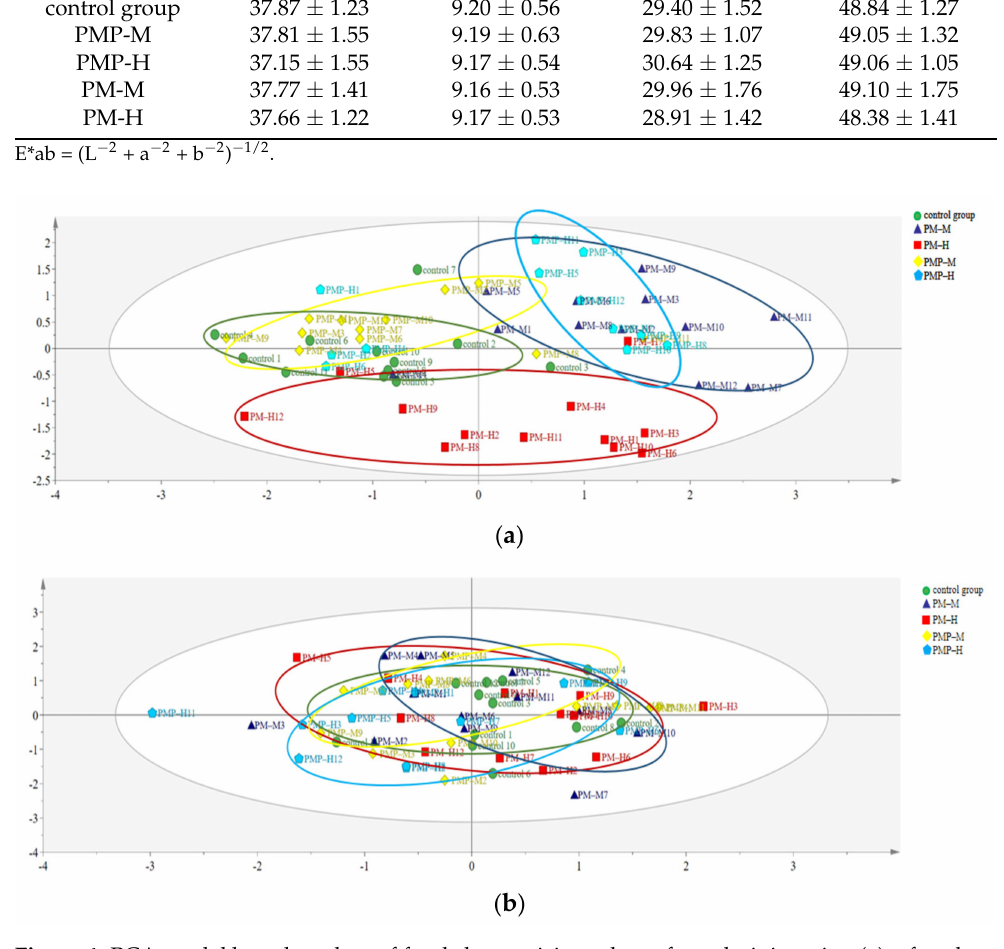
Figure 4. PCA model based on data of fecal chromaticity value: after administration ( a ); after drug withdrawal ( b